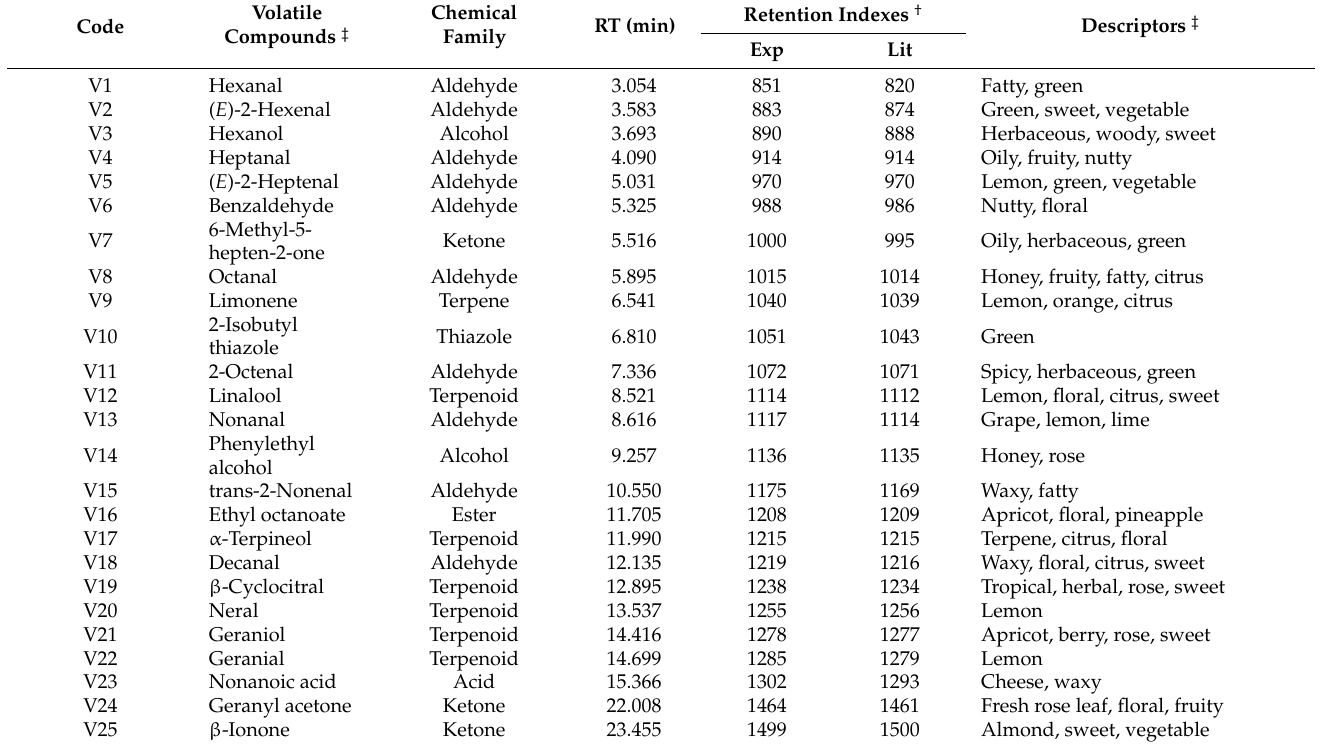
Table 5. Retention indices and sensory descriptors of the volatile compounds in cherry tomato